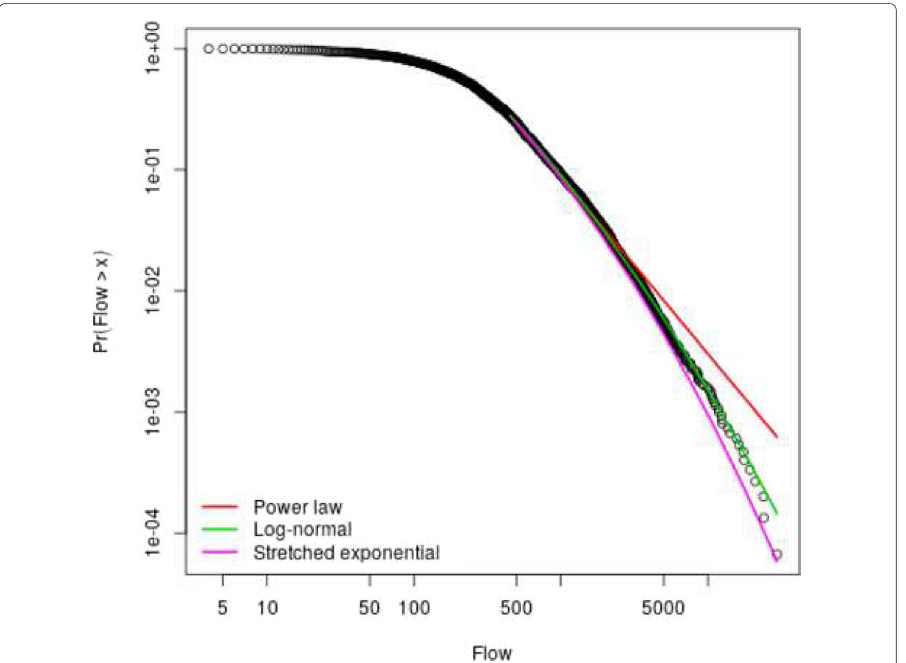
Fig. 1 Distributions fitted to flow data. We show the complementary cumulative distribution function (CCDF) for the flow data (points). The green line shows the best-fitting log-normal model, whilst red and pink lines depict the power law and stretched exponential (Weibull) distributions,